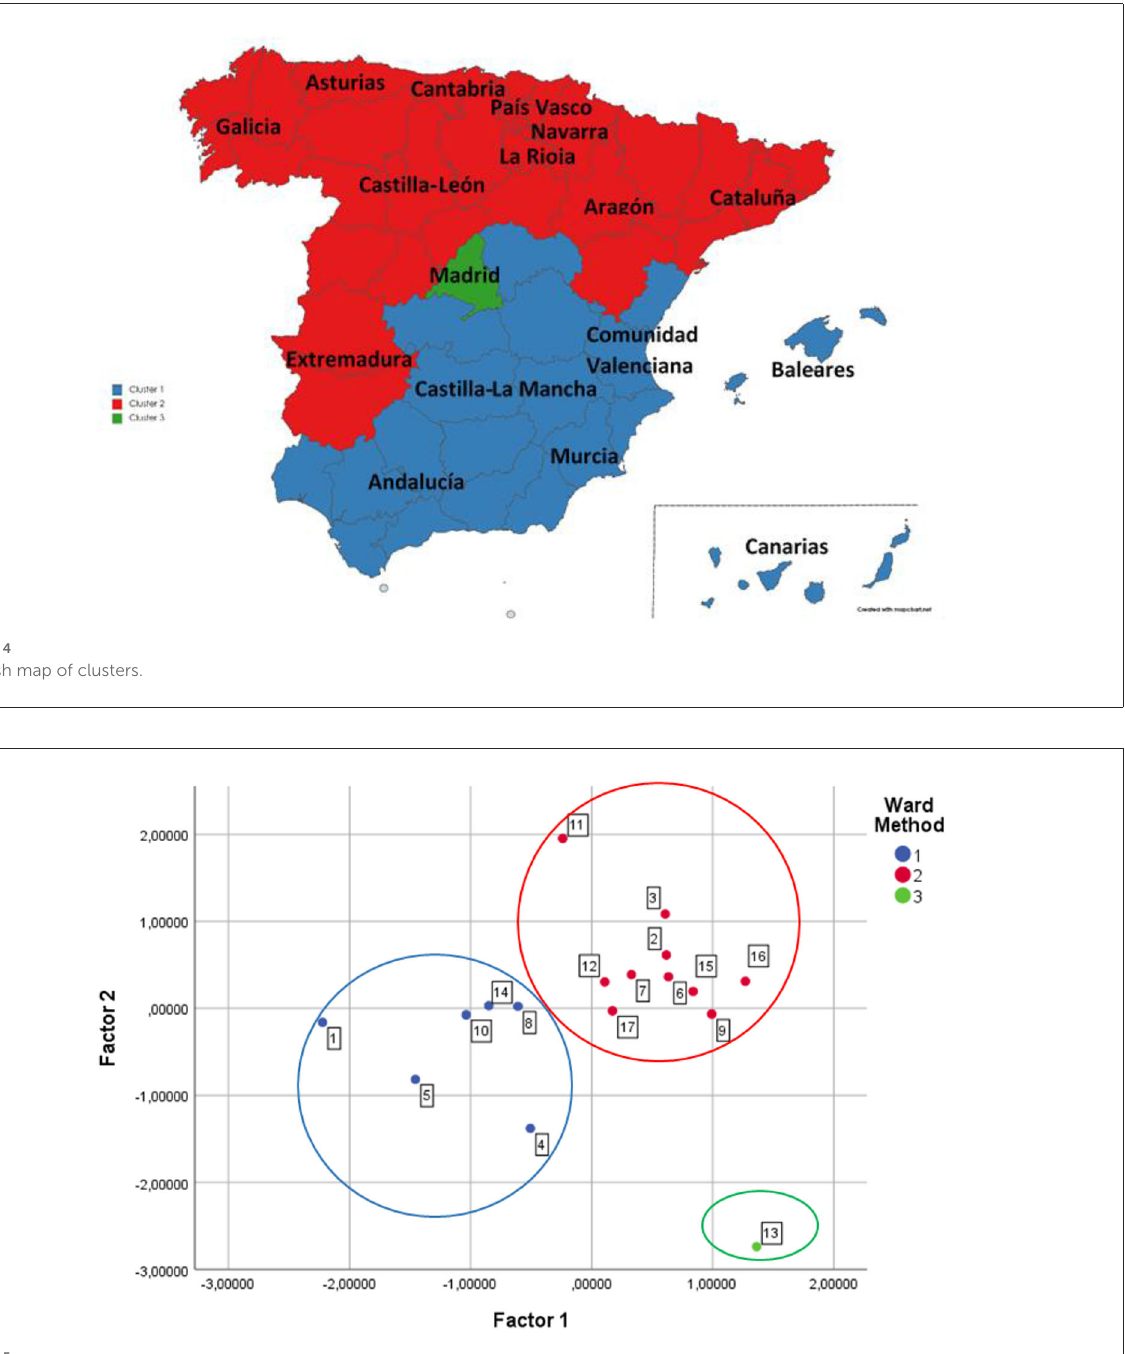
FIGURE5 Factors